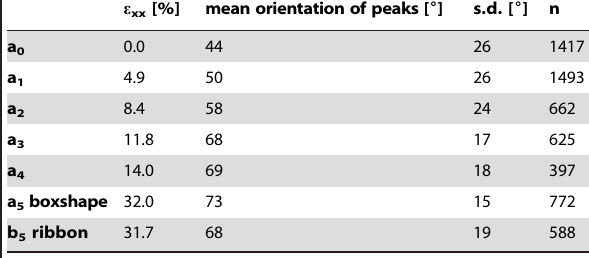
Table 3. Distribution of actin angles.